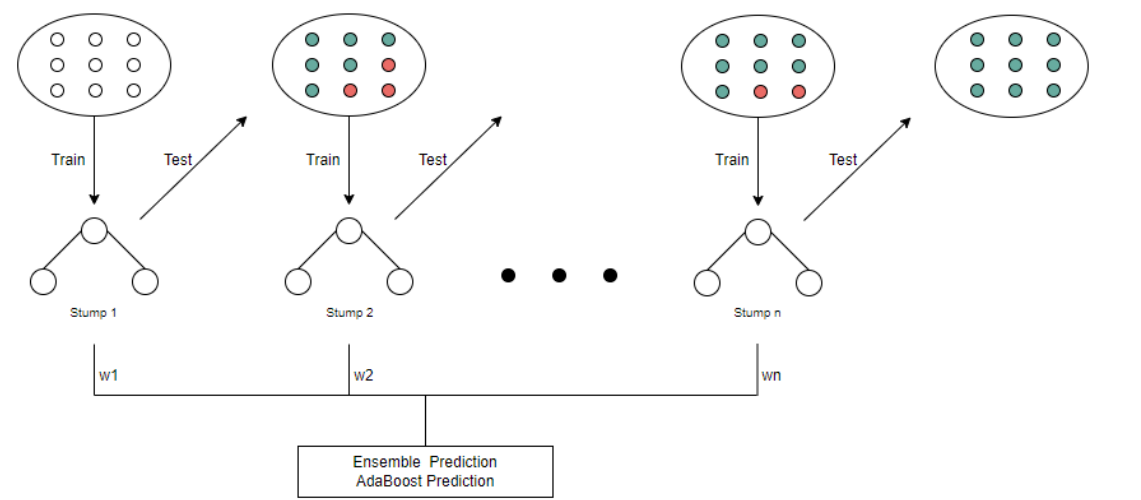
Figure 5. Structure of the gradient boosting model.